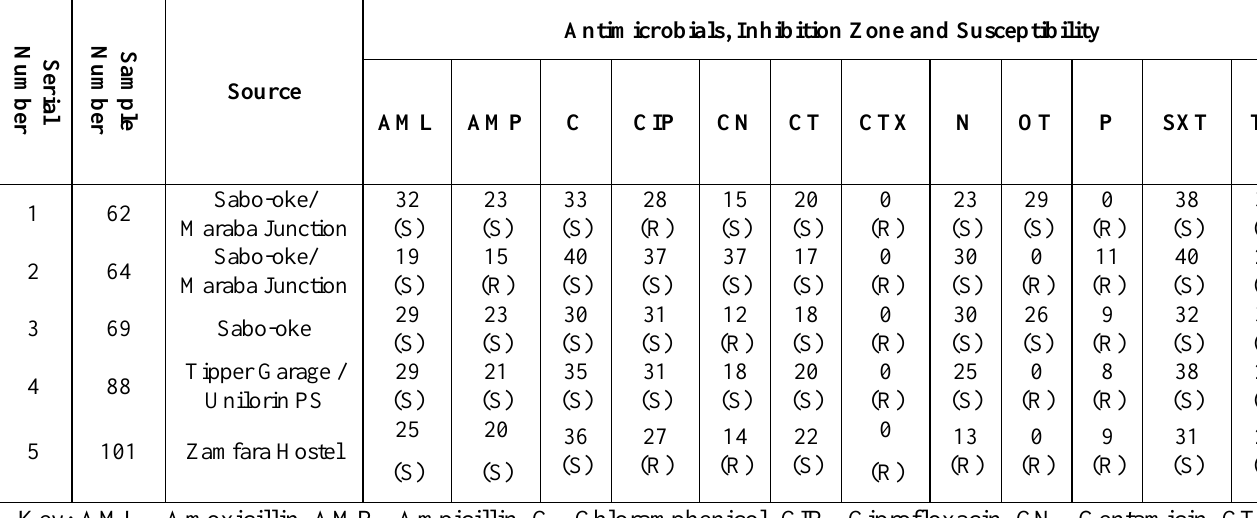
All (100%) the Salmonella isolates were sensitive to amoxicillin, chloramphenicol, colistin sulphate, sulfamethoxazole/trimethoprim and tetracycline. Four (80%) of the isolates were sensitive to ampicillin and neomycin while three (60%) isolates were susceptible to ciprofloxacin and gentamicin. Out of the isolates tested for sensitivity to oxytetracycline, two (40%) were sensitive while three (60%) were resistant to the antibacterial agent. On the other hand, all (100%) of the isolates were resistant to cefotaxime and penicillin G. Two (40%) Salmonella isolates were resistant to ciprofloxacin and gentamicin while one (20%) isolate each was resistant to ampicillin and neomycin (Table 2). The phenotypic antimicrobial resistance patterns recorded in this study were Table 2: Results of Antimicrobial sensitivity test carried out on isolated Salmonella spp . from Suya in Ilorin, Kwara state, Nigeria: